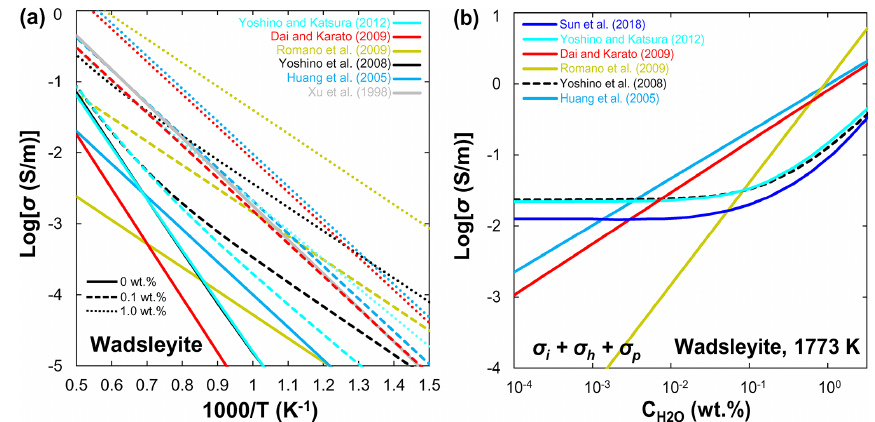
Figure 6. Compilation of electrical conductivity data of wadsleyite aggregates as a function of water content. (a) Log conductivity versus reciprocal temperature. (b) Log conductivity versus water content at 1773K. The number labels indicate water content in weight percent.